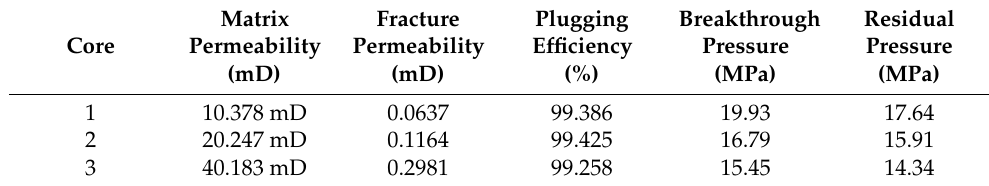
Table 3. Results of the plugging